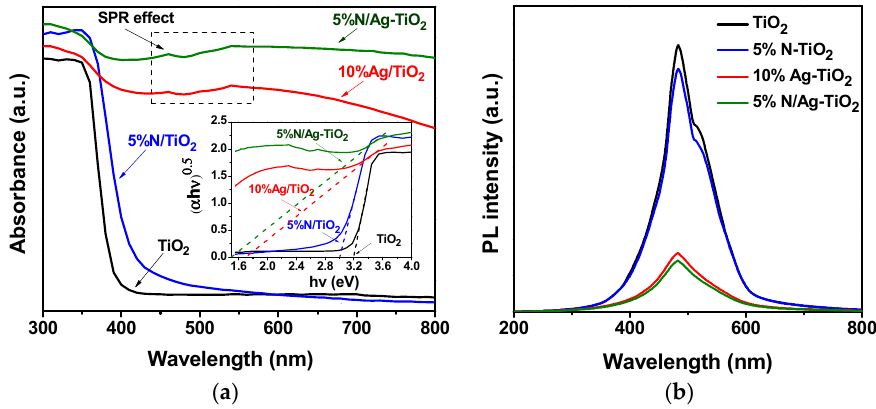
Figure 5. ( a ) UV-vis absorbance spectra and Tauc plot (inset) and ( b ) photoluminescence (PL) emission spectra of TiO 2 , 5% N-TiO 2 , 10%Ag-TiO 2 , and 5% N/Ag-TiO 2 .